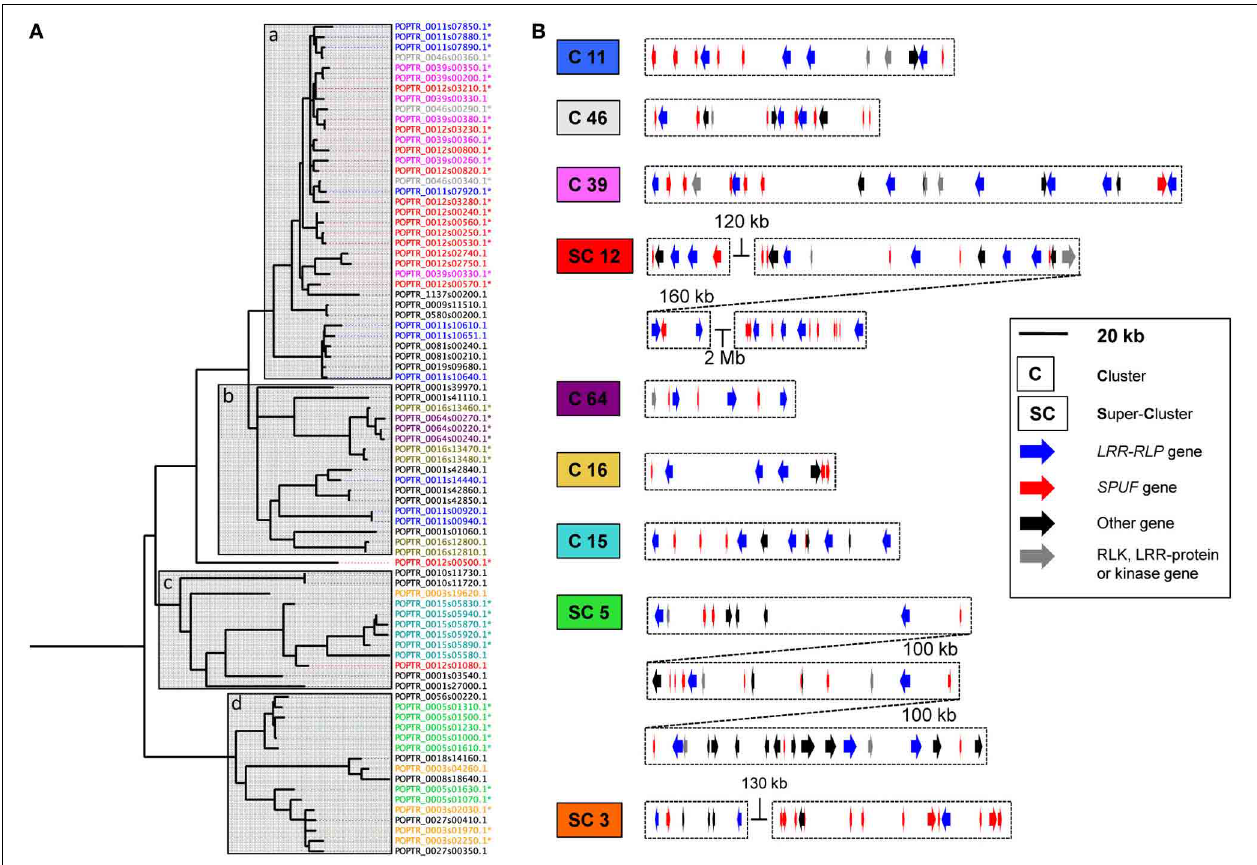
FIGURE 2 | Poplar LRR-RLP genes cluster with genes coding small-proteins of unknown function. (A) Phylogenetic tree of the 82 LRR-RLP from poplar constructed with the C3-D domains. Almost all sequences gather into four main clades (a, b, c, and d) indicated by gray boxes. IDs have been colored according to their presence on similar chromosomes (chr.) or scaffolds (scf.), as follow: chr.3: orange; chr.5: green; chr.11: blue; chr.12: red; chr.15: cyan; chr.16: dark-yellow; scf.39: pink; scf.46: